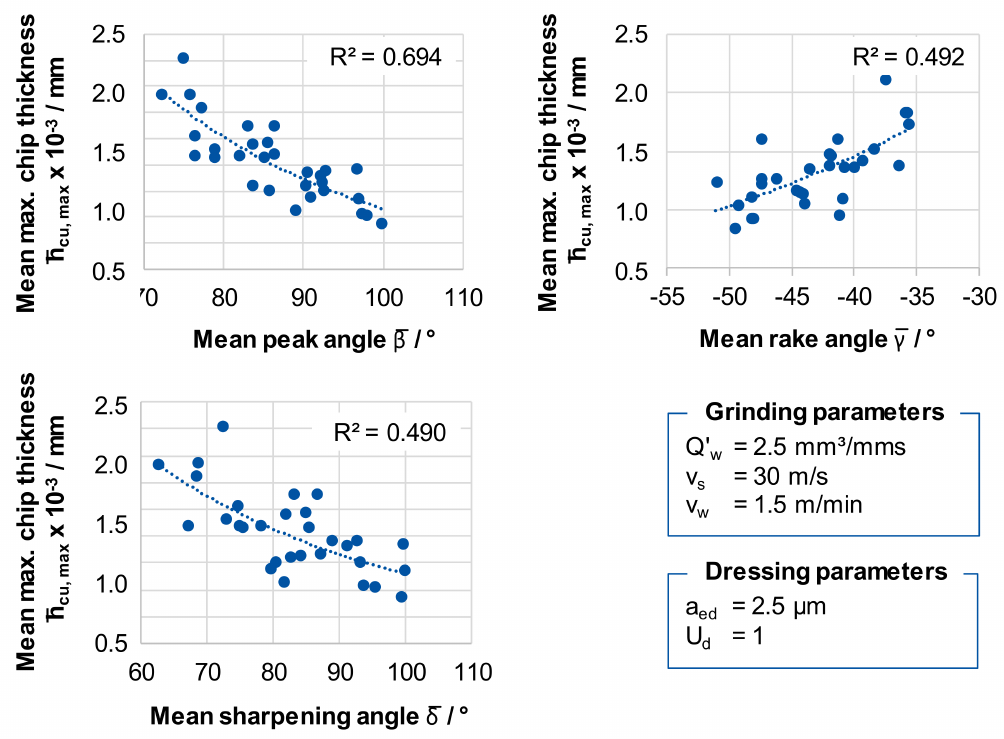
Figure 11. Correlation between kinematic engagement grain angles and the mean maximum chip